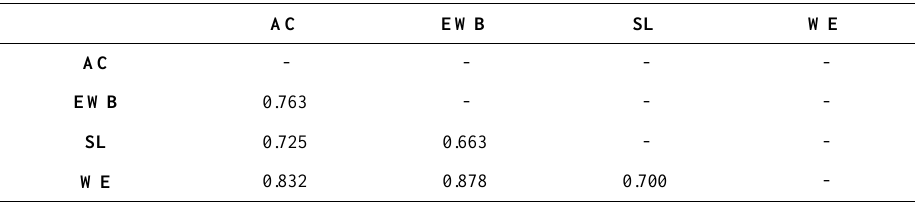
Table 4. Heterotrait-Monotrait (HTMT)